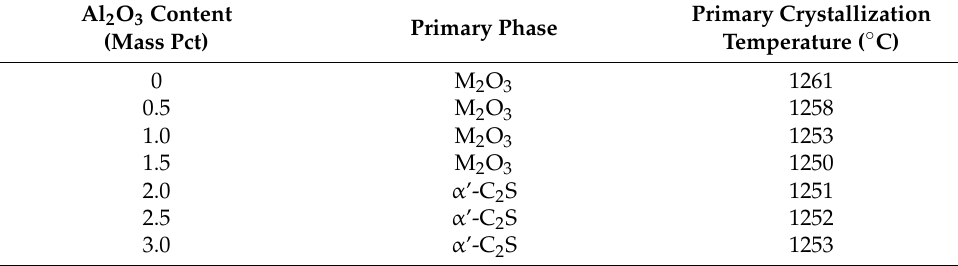
Table 6. Changes of primary crystallization phase and temperature after adding Al 2 O 3